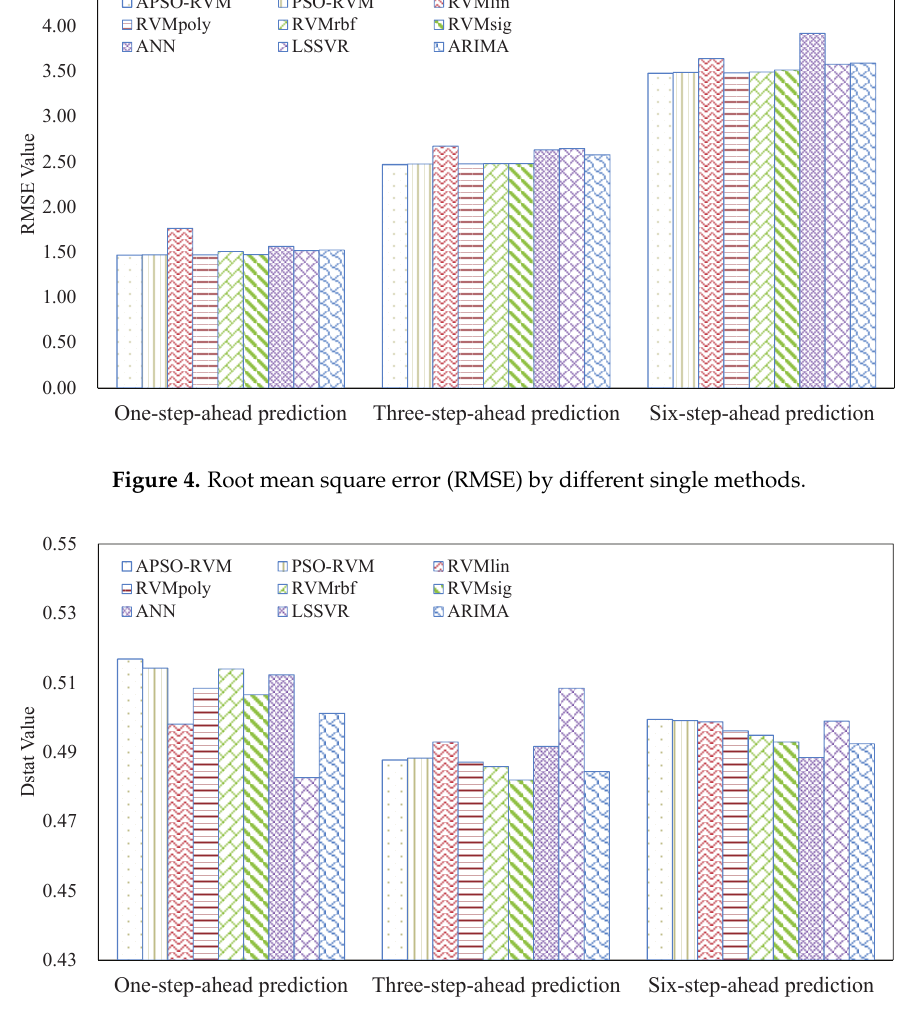
Figure 5. Dstat by different single